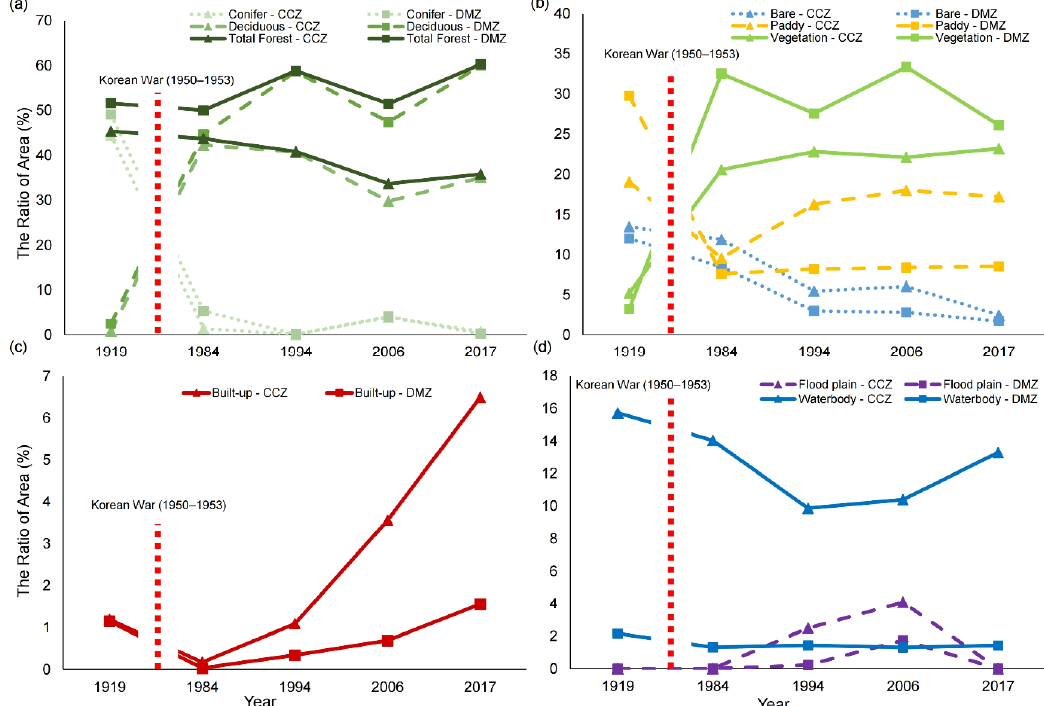
Figure 5. Changes in land-use patterns in western DMZ and CCZ in Paju-si and Yeoncheon-gun over 100 years (1919–2017) in Korea. ( a ) Changes in forest area. Forests classified as coniferous and deciduous, and relative area of total forest is indicated. ( b ) Changes in areas of vegetation, rice paddies, and bare soil. ( c ) Changes in areas of artificial structures, including built-up (such as roads) and agricultural (such as ginseng fields) facilities. ( d ) Changes in water bodies and floodplain (lacking